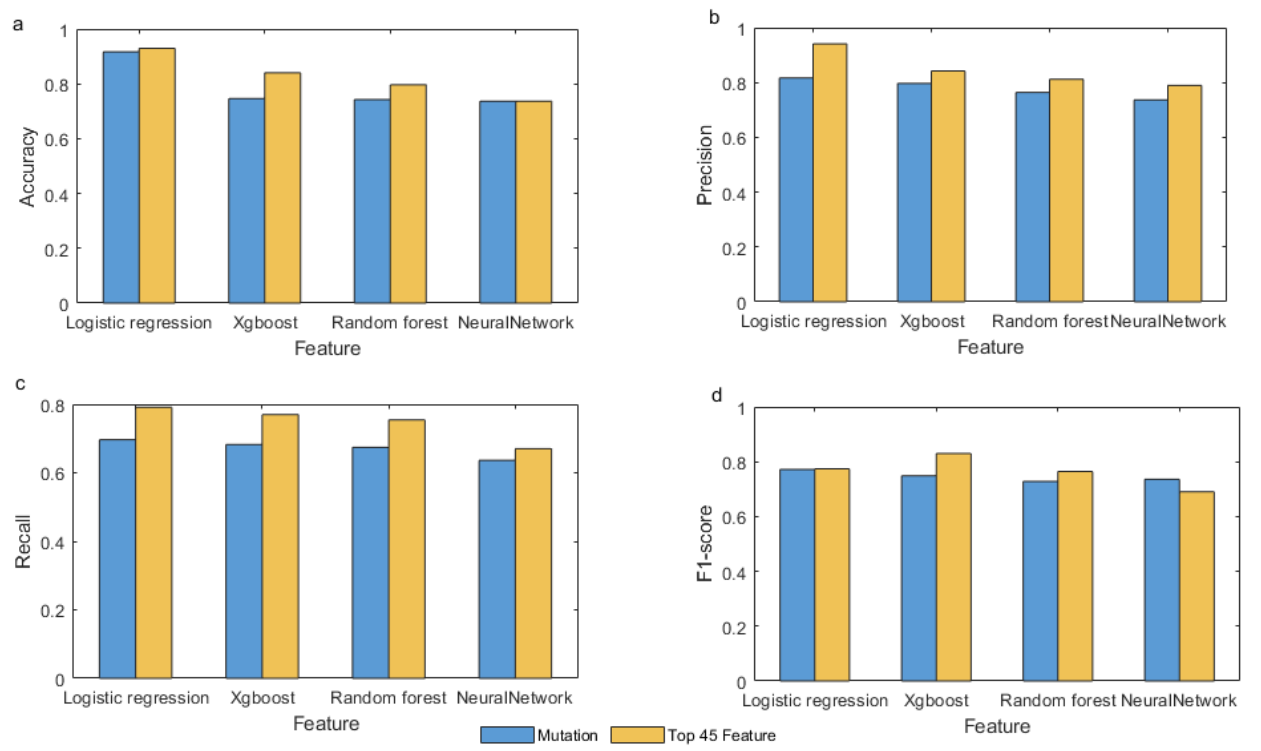
Figure 5. Compare the features of mutation types with the top 45 features, ( a – d ) in four different machine learning